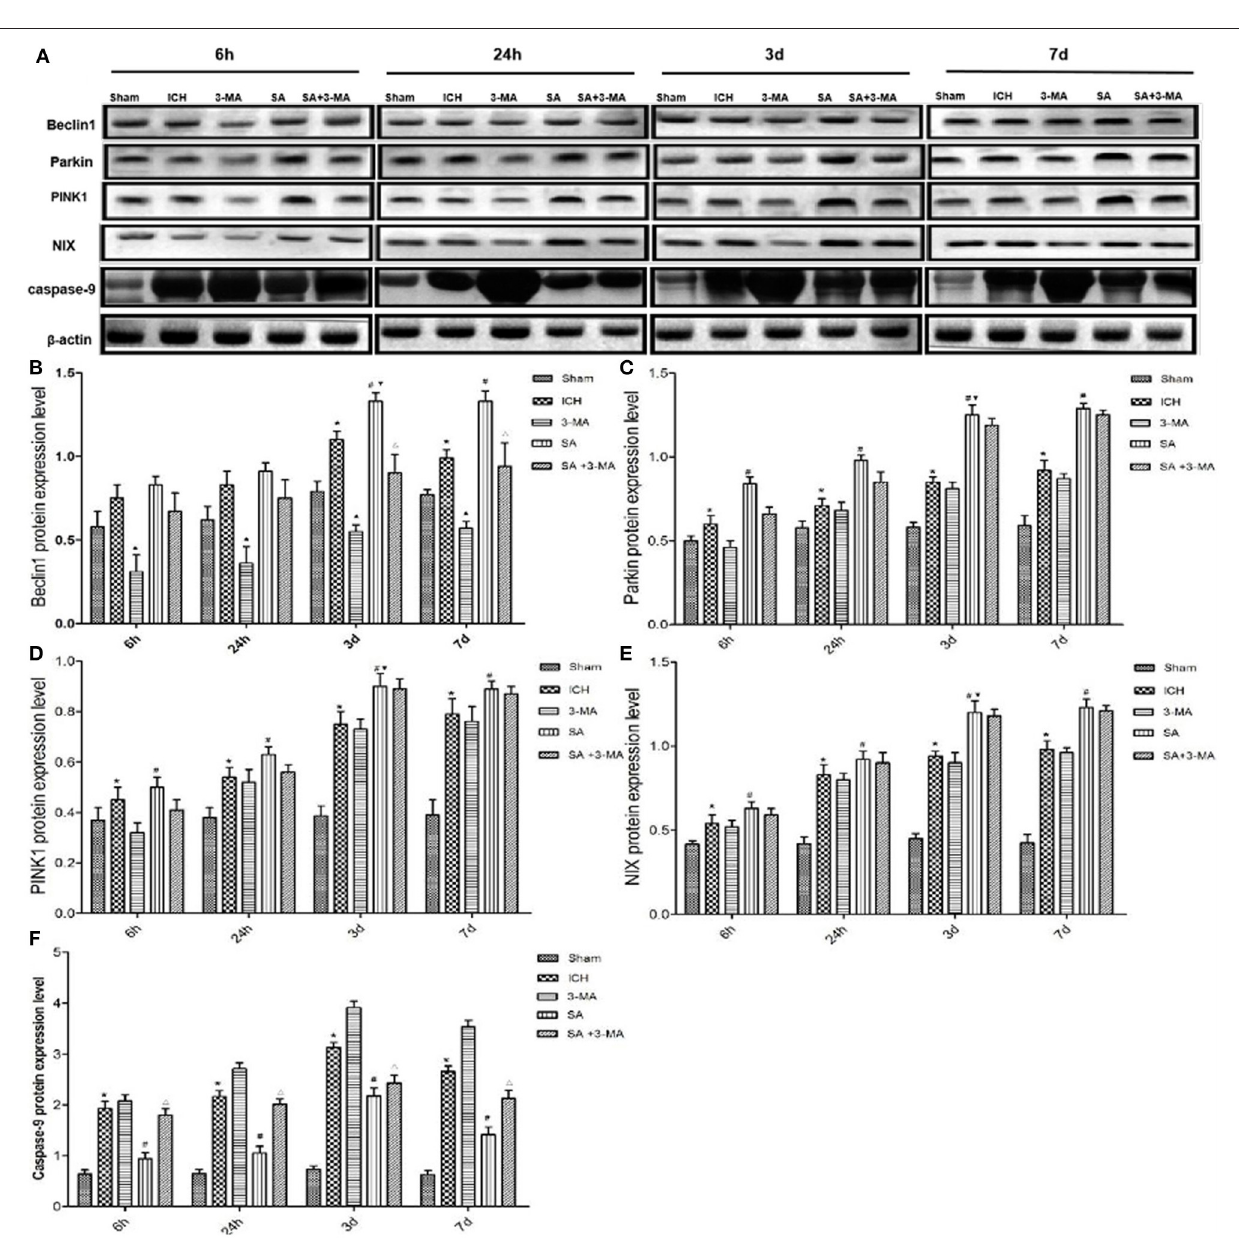
FIGURE 7 | Western blotting: SA upregulates mitophagy-related proteins and decrease the apoptosis-related protein after ICH. (A) Western blotting of proteins relevant to mitophagy activation in rat brain tissue after ICH. Protein levels were normalized to levels of β -actin as loading control. (B–F) Quantitation of levels of Beclin1, Parkin, PINK1, NIX and Caspase-9. Data are mean ± SD ( n = 6). Significance was assessed using one-way ANOVA, followed by Tukey’s post hoc test. * P < 0.05, vs. sham; # P < 0.05, vs . ICH; N P < 0.05, vs . ICH; 1 P < 0.05, vs . SA; H P < 0.05, vs . 24h SA group. ICH, intracerebral hemorrhage; SA, scalp acupuncture; 3-MA,